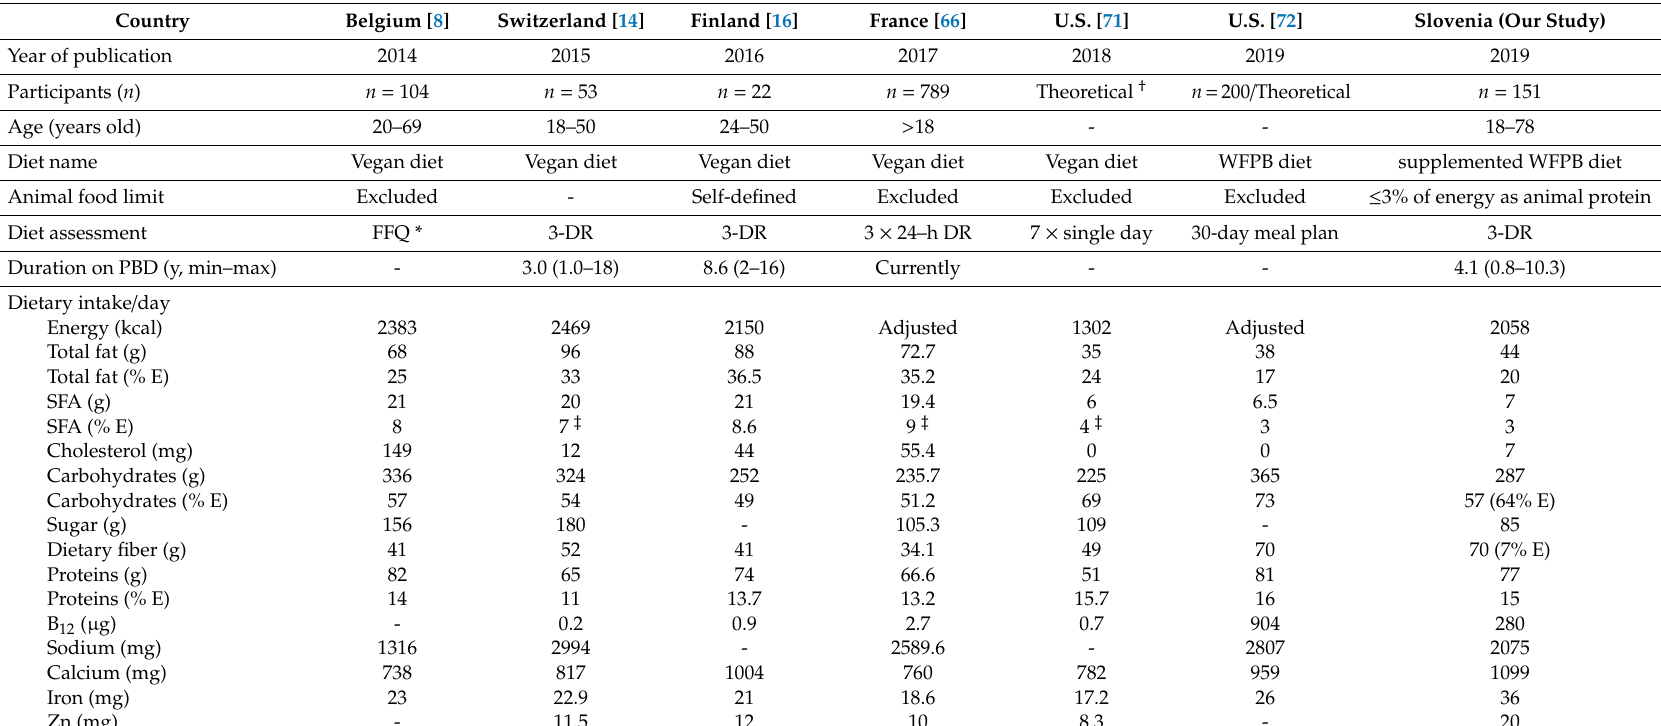
Table 7. Dietary intake comparison with di ff erent cross-sectional studies on PB